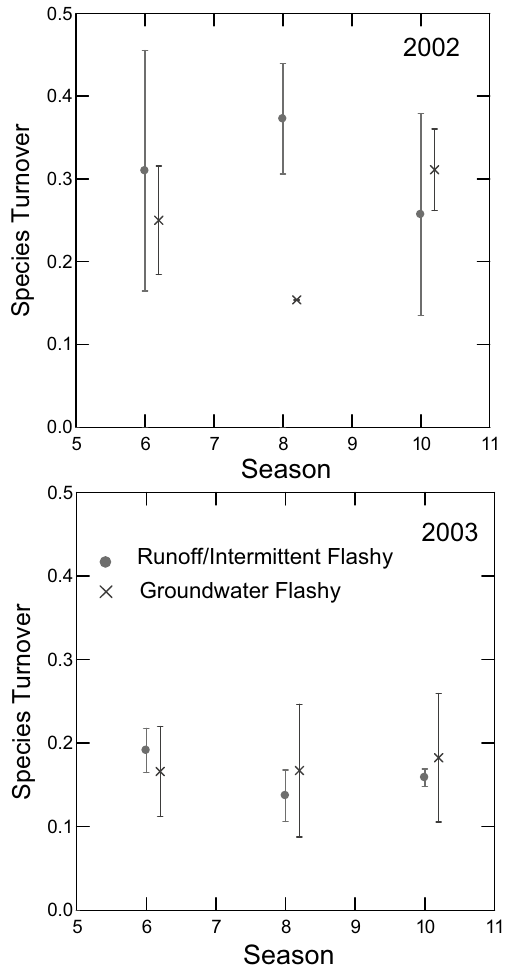
Figure 5. Mean (± SE) seasonal total fish species turnover in Runoff/Intermittent Flashy and Groundwater Flashy streams in 2002 and 2003. Turnover times are spring-early summer = 6, early summer-summer = 8 and summer-autumn = 10. Points are jittered for ease of viewing. Figure produced with SYSTAT